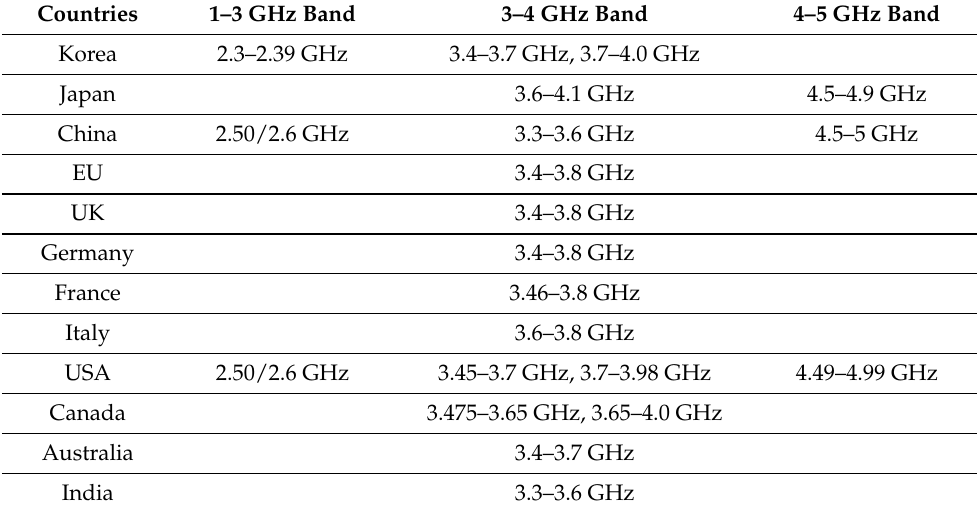
Table 12. The global 5G sub-6 GHz mid-band spectrum .